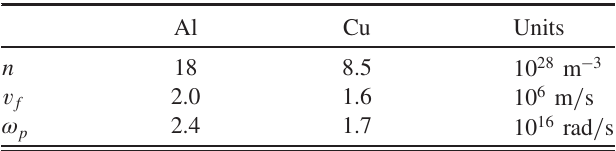
TABLE II. Free-electron Fermi gas model parameters for Al and Cu